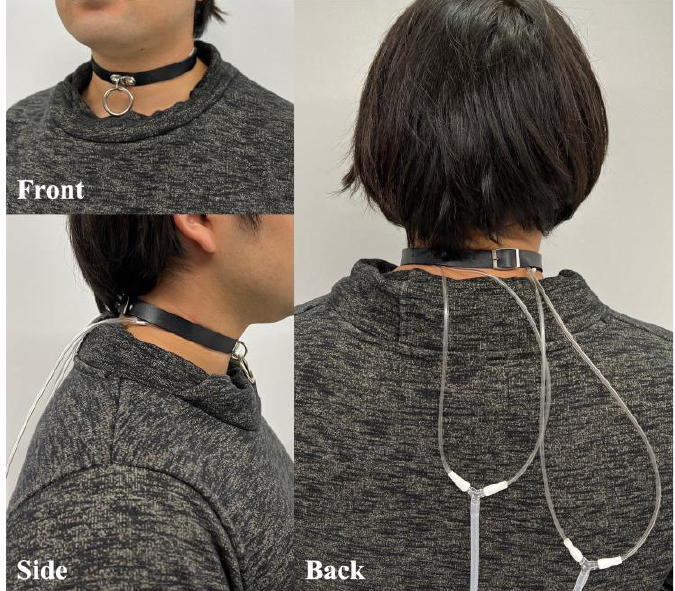
Figure 1. The choker-type haptic presentation device equipped with pneumatic actuators.